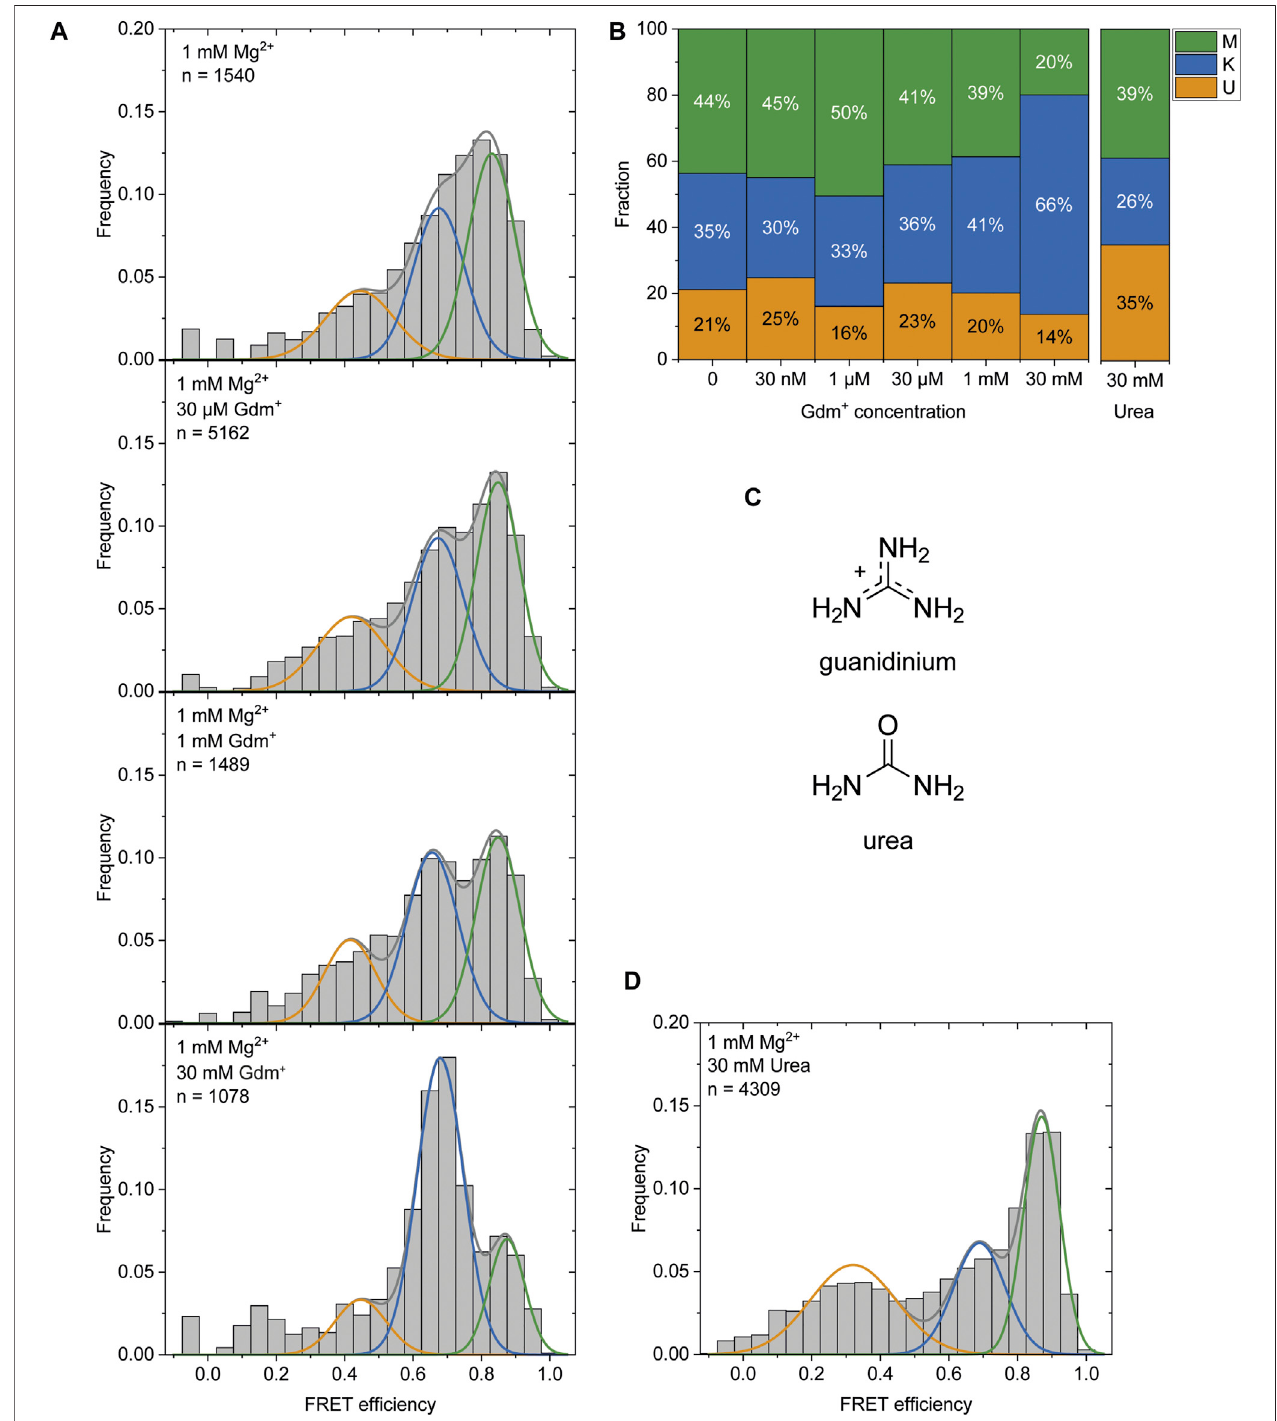
FIGURE 6 | (A) Histogram analysis of the Gdm + titration at constant 1 mM Mg 2+ . The data were fi tted with three Gaussian fi ts showing the change between the K-state (blue) and the M-state (green) with increasing Gdm + concentration. (B) Fractions of molecules adopting the individual states based on the area under the fi tted curves. (C) Structures of Gdm + and urea. (D) Histogram analysis at 1 mM Mg 2+ with 30 mM urea.